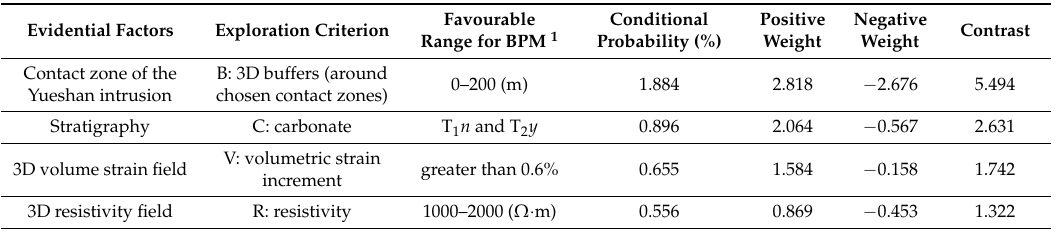
Table 4. Exploration criteria determined for prospectivity mapping from evidential